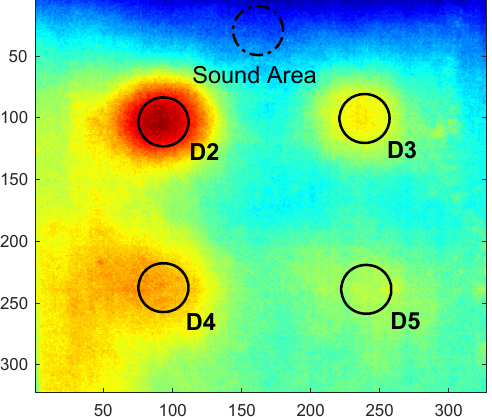
Figure 9. Infrared (IR) image snapshot, showing the areas that were placed while calculating the spatial medians of temperature data over time for the four defective areas (D2, D3, D4, and D5) and the selected sound area (S).